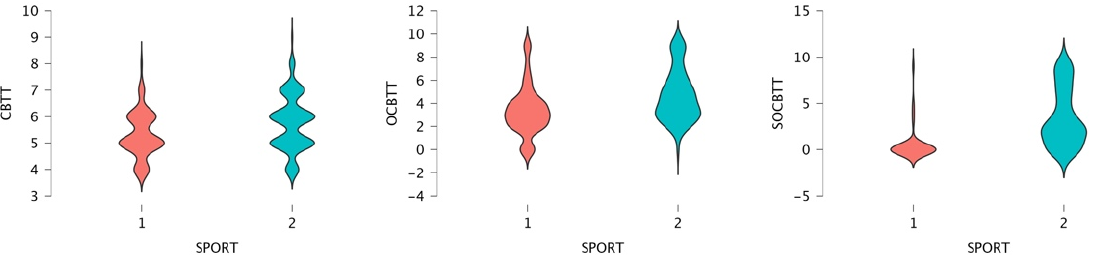
Figure 5. Violin plot for the span and sport conditions (1 = athletes; 2 = non-athletes) through the CBTT, OCBTT and SOCBTT. CBTT, OCBTT and